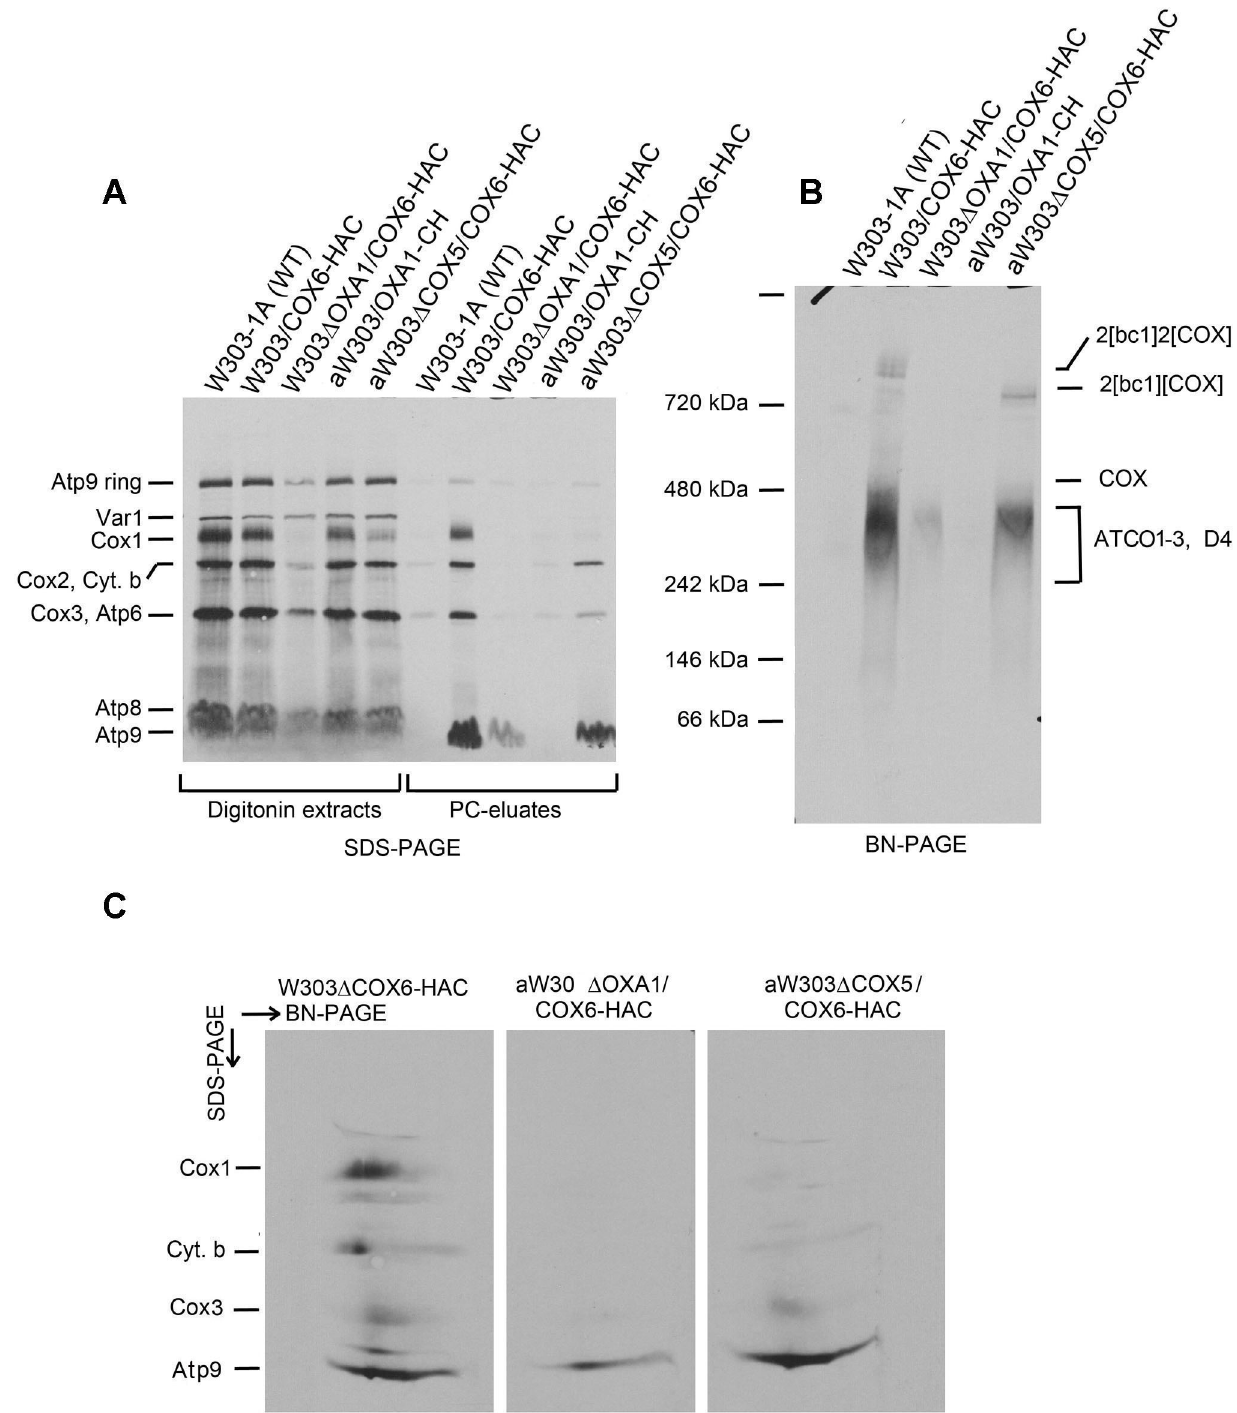
Fig 5. Analysis of Atco complexes in oxa1 and cox5 mutants. Mitochondria were prepared from the wild type W303-1A, a strain expressing Cox6-HAC without (W303/COX6-HAC) and with a null mutation in oxa1 (W303DOXA1/COX6-HAC) or cox5a (aW303DCOX5/COX6-HAC) and an oxa1 null mutant (aW303DOXA1). The mitochondria were labeled with 35 S-methionine/cysteine for 20 min, extracted with 2% digitonin and the extracts purified on protein C antibody beads. A. The digitonin extracts and the purified protein fraction in the eluates from the beads (PC eluates) were separated by SDS- PAGE on a 12% polyacrylamide gel. B. The eluates from the protein C antibody beads were separated in a single dimension on a 4–13% polyacrylamide gel by BN-PAGE. C. The eluates from the indicated strains were separated by BN-PAGE in the first dimension and the region containing Atco, by SDS- PAGE in the second dimension. The radiolabeled band of each gel is identified in the margins.